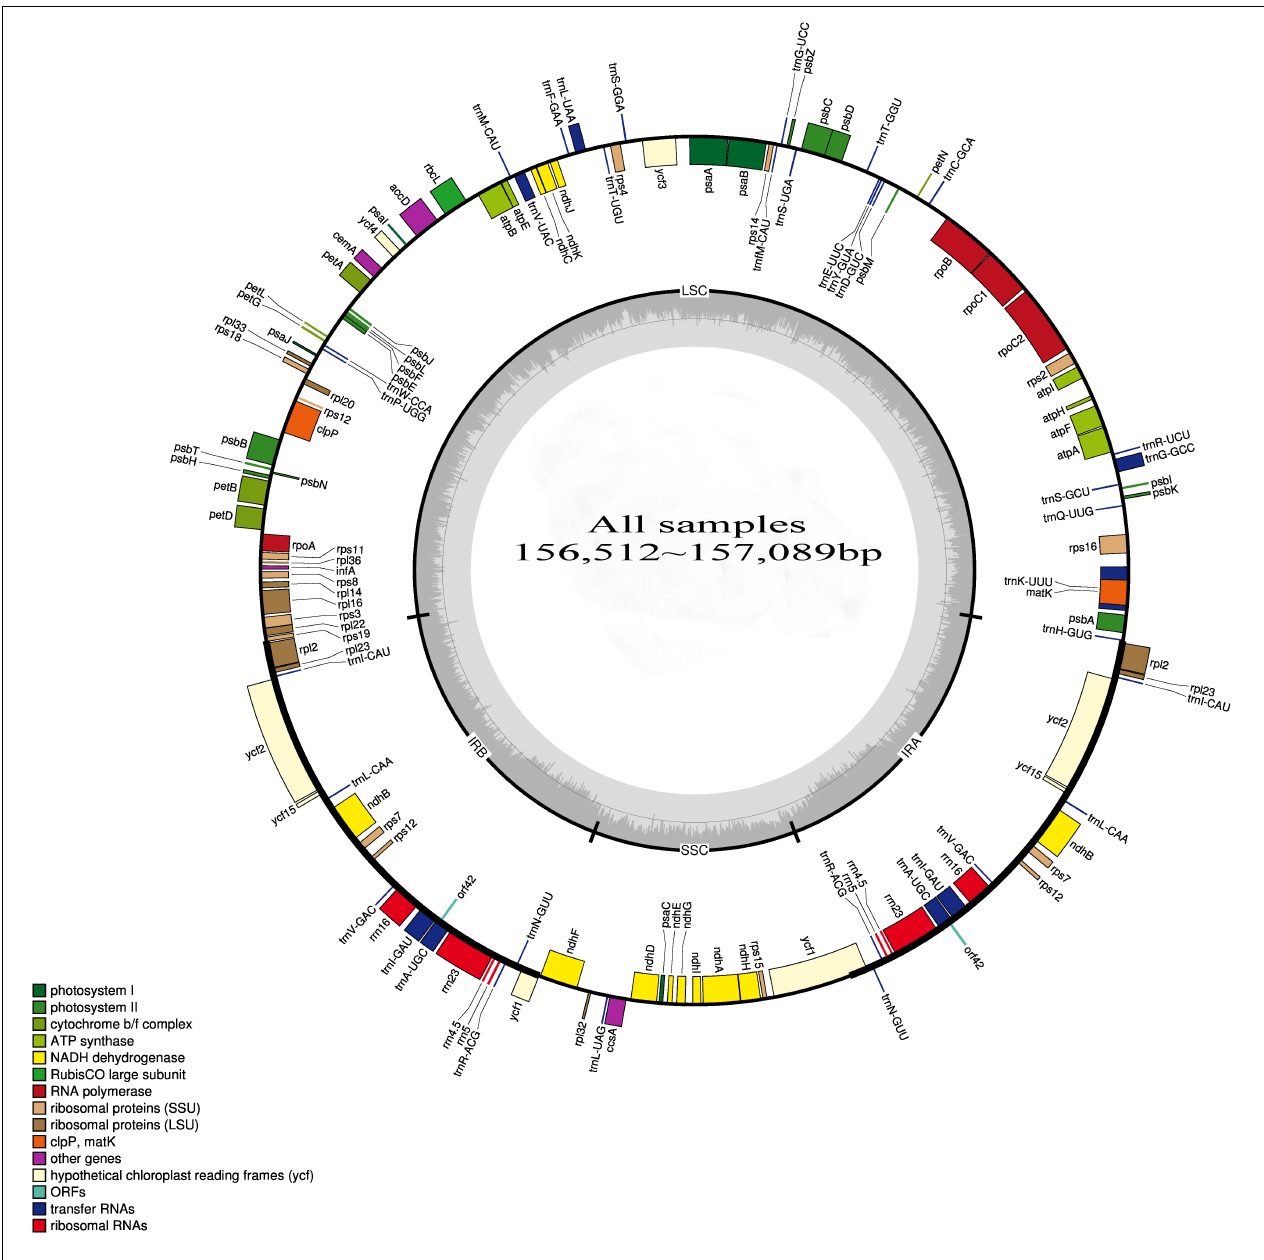
FIGURE 1 | Gene maps of the chloroplast genomes of all 13